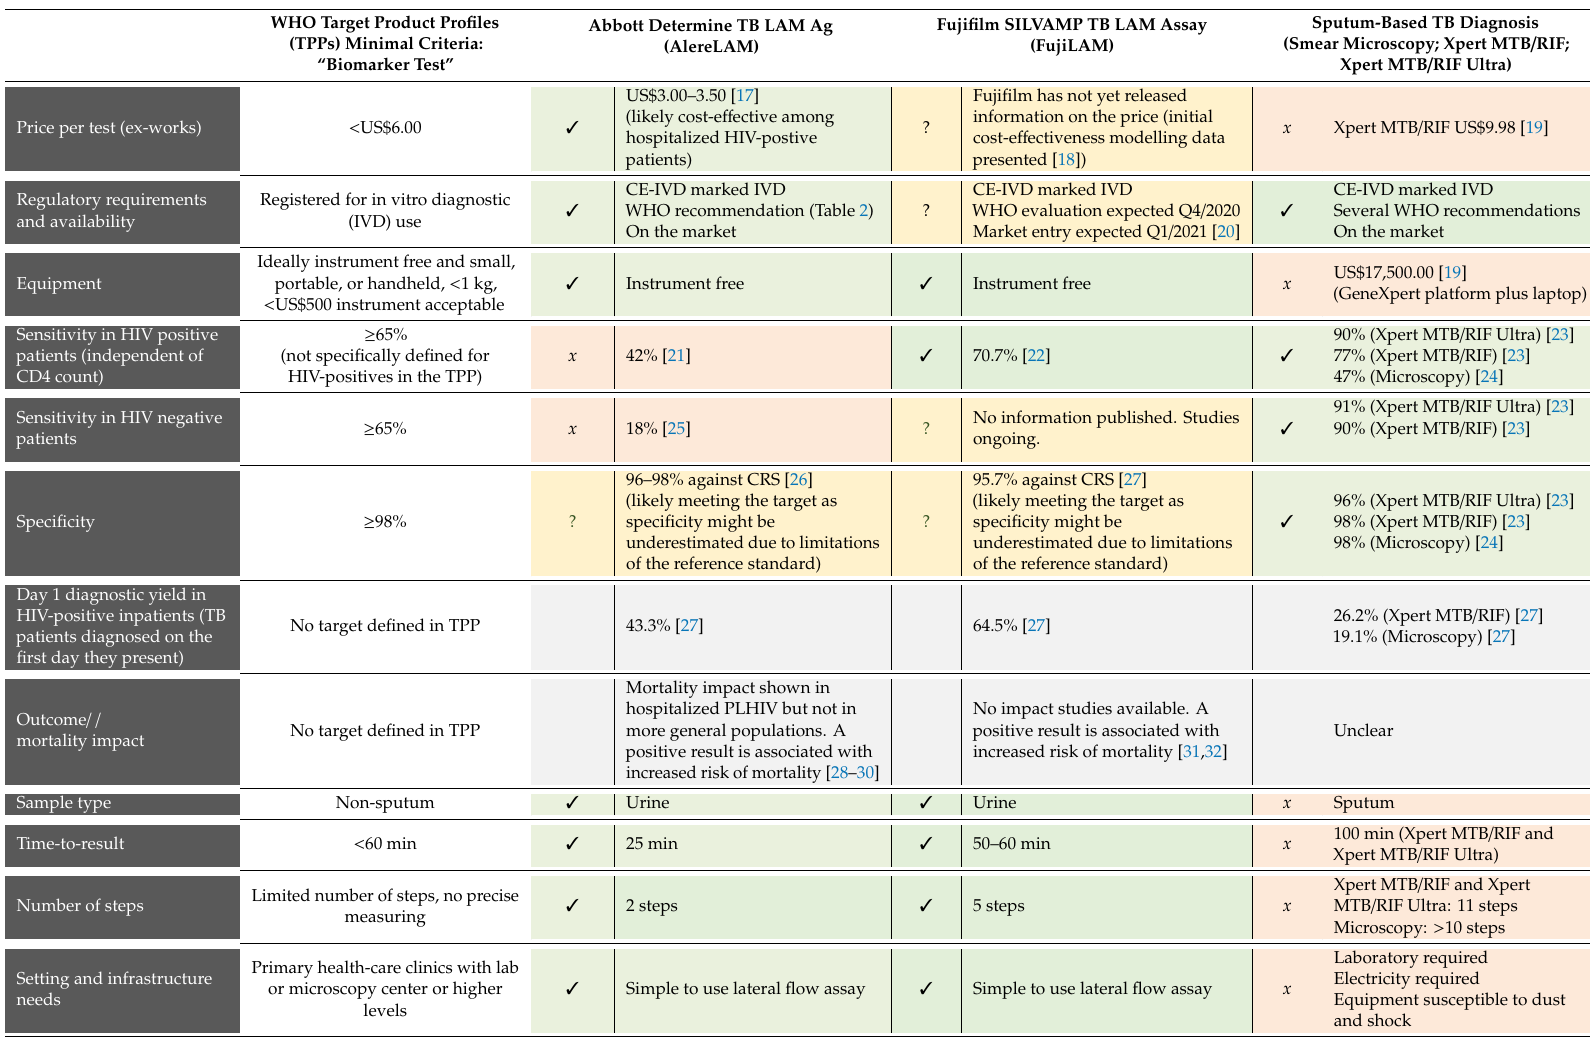
Table 1. Status of the available AlereLAM, FujiLAM, and sputum-based tuberculosis (TB) diagnosis vs. biomarker target product profile (TPP) [4]. WHO: World Health Organization; PLHIV: people living with HIV; TPP: Target product profile; CRS: Composite reference standard; IVD: in vitro diagnostic; “ (cid:51) ” indicates that the TPP minimal criteria is met; “ x ” indicates that the TPP minimal criteria is not met; “?” indicates that it is currently unclear whether the TPP criteria is